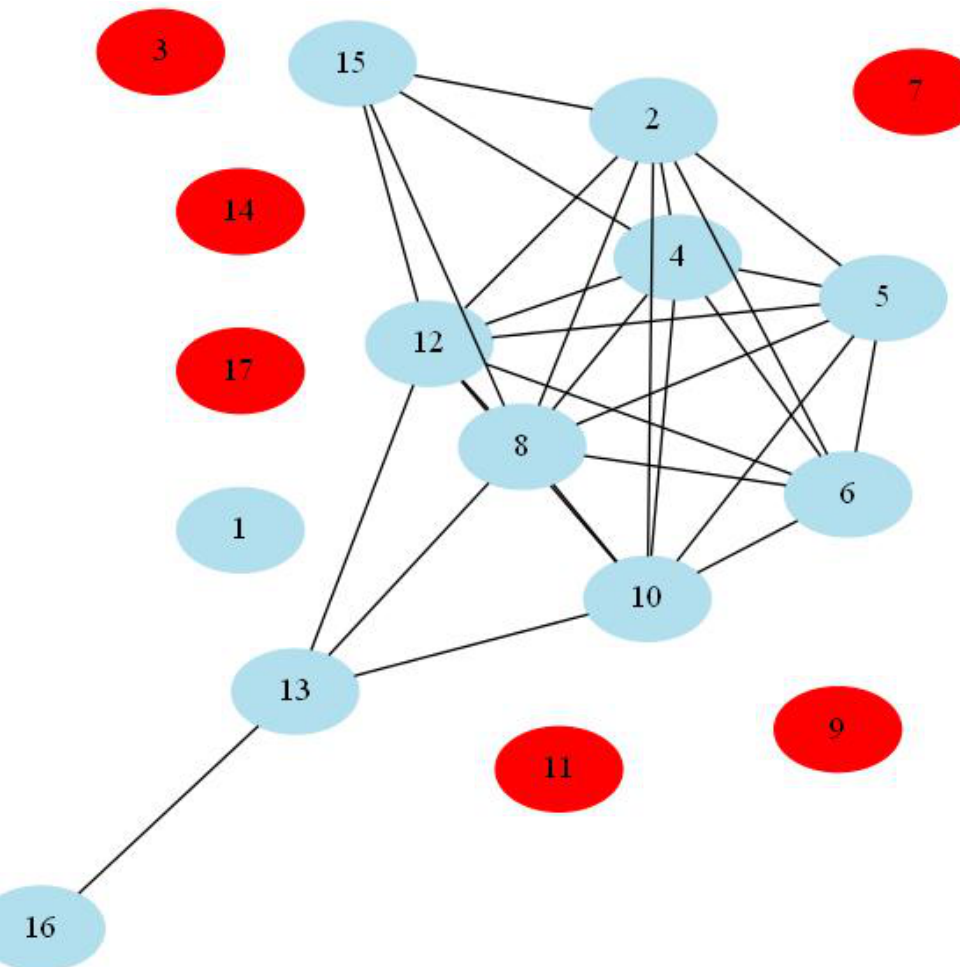
Figure 6: As Fig. 5, with the Manhattan distance Trying to get a similar visualization with the Canberra distance, we were in for a surprise, as it can be seen in Fig. 7. After checking out for errors, and while still thinking of not including Fig. 7 here, we came up with a controversial claim, which we expose for debate: In a (highly unlikely) question posed by a (highly unlikely) fictitious candidate reader of the novel, “ since I keep on hearing about the highly heterogeneous structure of the novel, it should be possible to read roughly half of the book and still be able to grasp the most out of it; now, which chapters should I read? ”, we claim that the connected chapters in Fig. 7 (i.e. the V. storyline chapters minus Chapter 14, framed by the first and the last of the Profane storyline chapters) constitute a possible valid